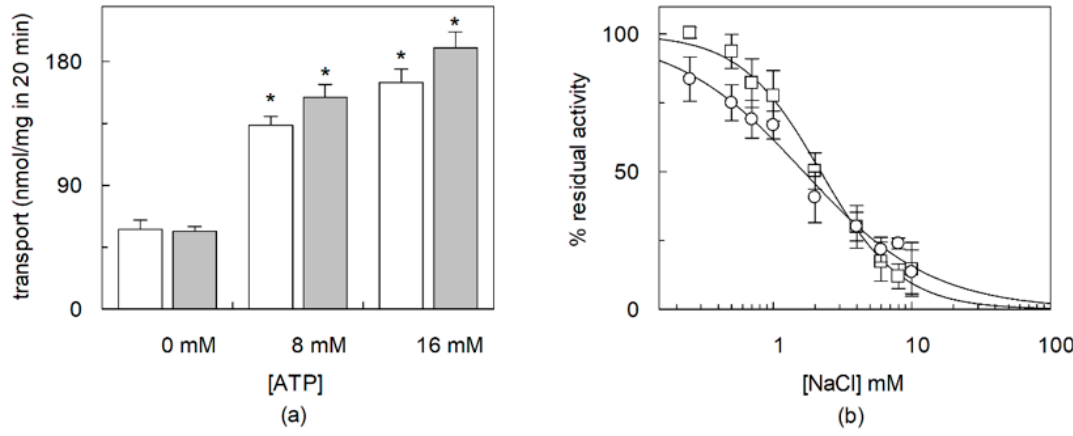
Figure 6. Effect of CHS on regulation of OCTN1 by ATP or NaCl. The recombinant OCTN1 was reconstituted in liposomes as described in Section 4.5. except that in the presence of 8.3% CHS corresponding to 83 µg CHS/mg total lipids and ( a ) in the presence of the indicated ATP concentrations. Transport was started adding 0.1 mM [ 14 C]-TEA (white column, ○ ) or [ 3 H]-acetylcholine (grey column, □ ) at time zero to proteoliposomes. ( b ) Increasing NaCl extraliposomal concentration were added together to the radioactive substrates. The transport reaction was stopped at 20 min. Percent residual activity with respect to the control data were interpolated in an IC 50 equation (Dose-response curves). The values are means ± SD from three experiments. Significantly different for * p < 0.01 as calculated from Student’s t test analysis.